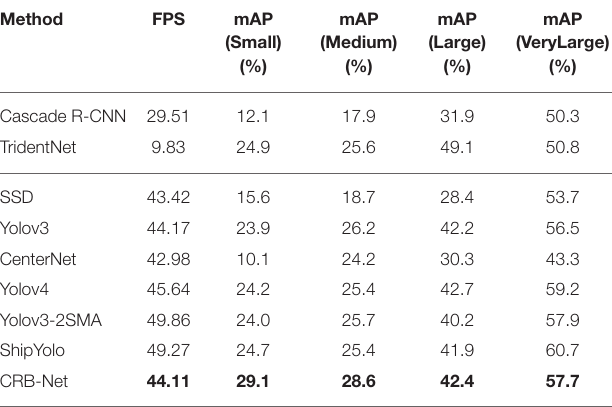
TABLE 5 | Detection performance for objects of different